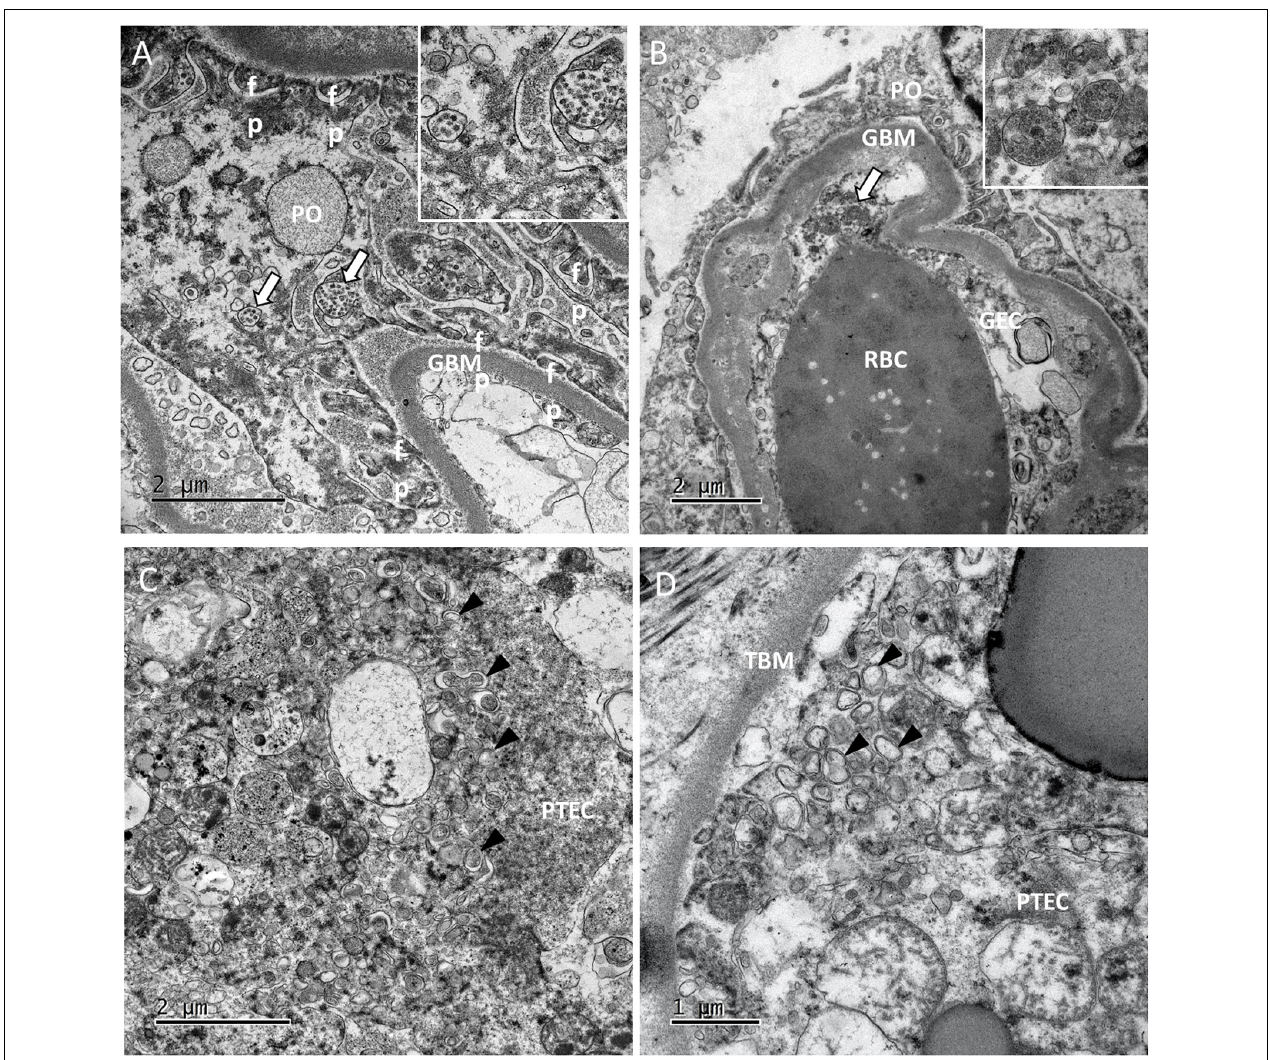
FIGURE 3 | Ultrastructural findings in the kidneys. (A) In glomeruli of patient 5, large numbers of viral particles in intracellular vacuoles (white arrows; see the inset for a higher magnification image) were found in podocytes (PO). GBM, glomerular basement membrane; fp, foot process. (B) In patient 10, glomerular capillaries showed signs of blood stasis. We also noticed vacuoles filled with smooth viral particles (white arrow) in the cytoplasm of glomerular endothelial cells (GECs). (C,D) In the tubules of patient 10 and 11, proximal tubular epithelial cells (PTECs) contained an abundant network of double-membrane vesicles (DMVs; black arrowheads), a marker of SARS-CoV-2 replication. TBM, tubular basement membrane. The DMVs are easily recognizable, with an inner membrane and an outer membrane [white arrowheads in the insets in panels (C,D)